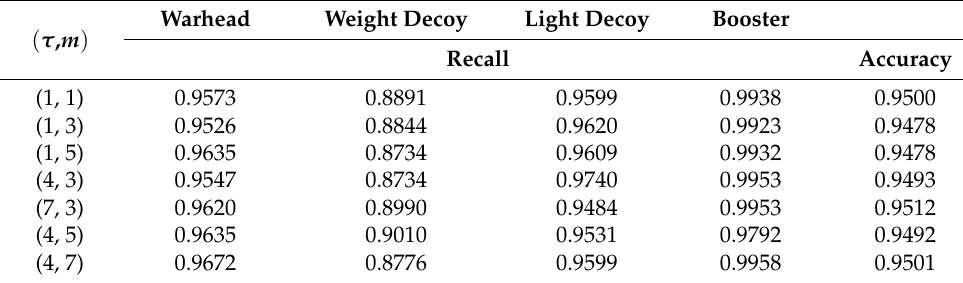
Table 5. The classification evaluation based on